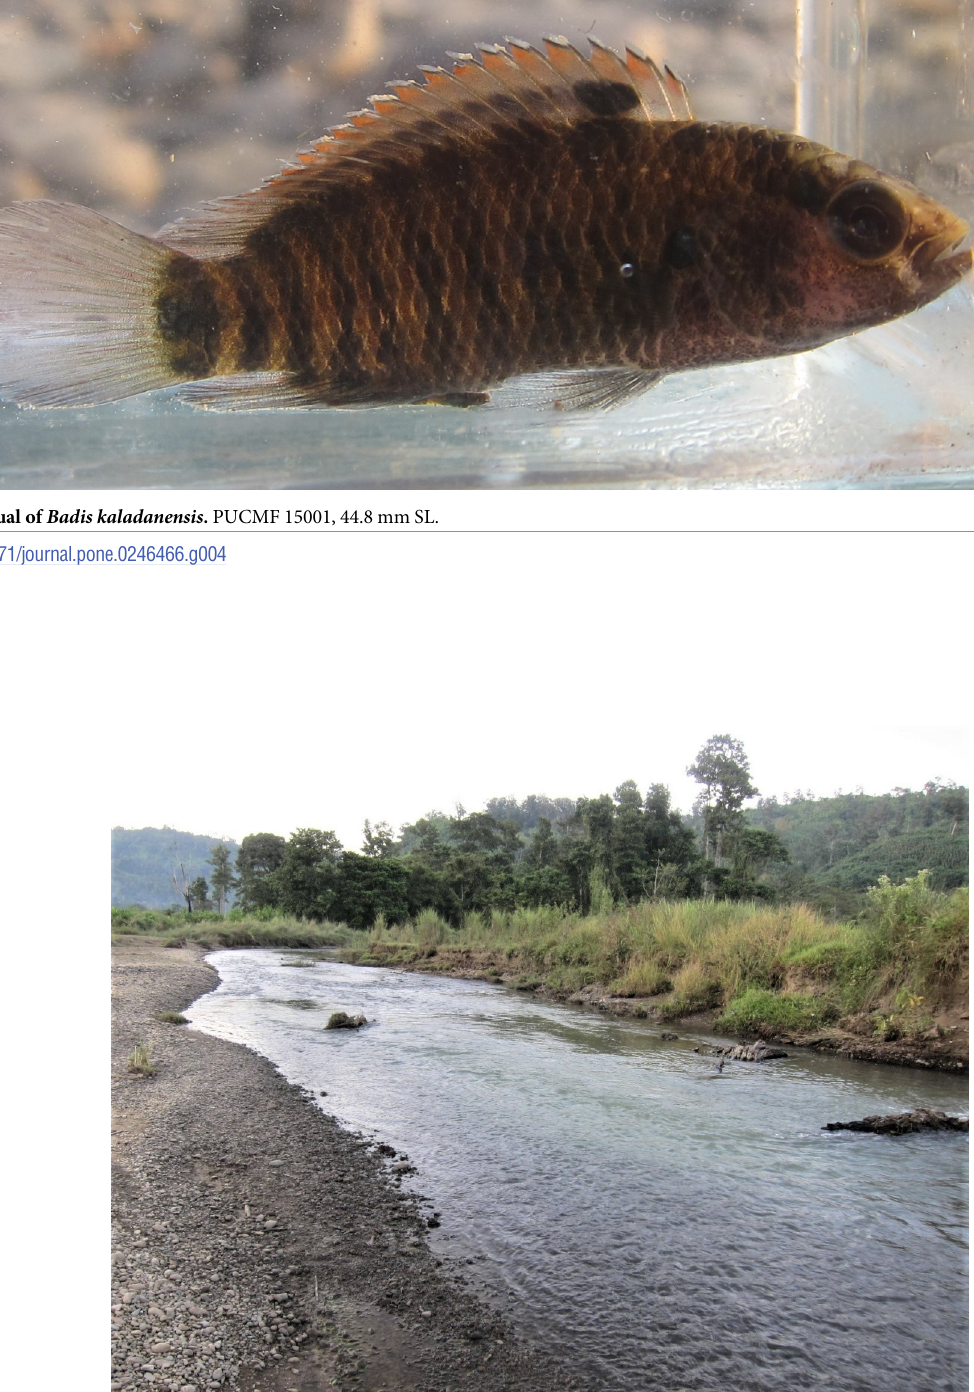
PLOS ONE | https://doi.org/10.1371/journal.pone.0246466 July 28,